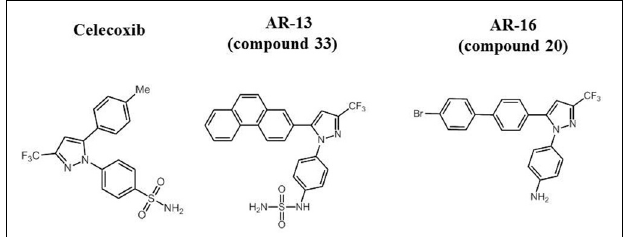
FIGURE 1 | Molecular structure of celecoxib and its derivatives AR-13 and